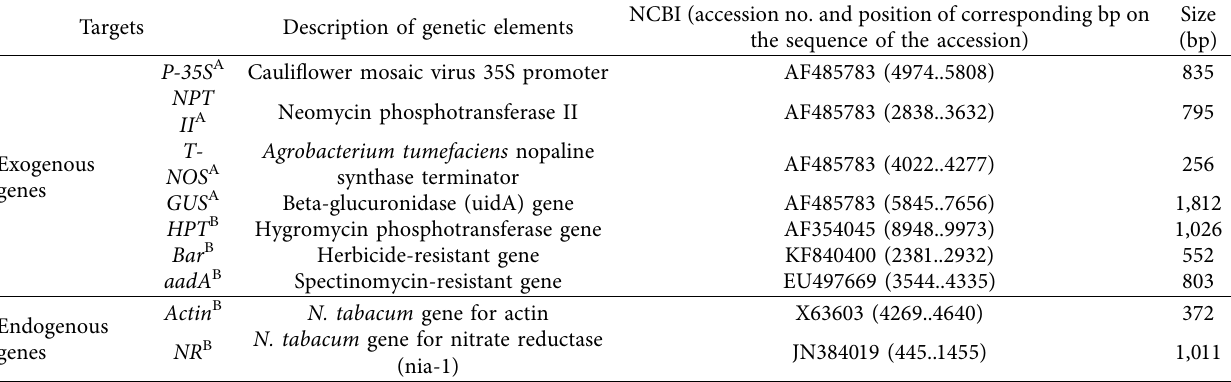
Figure 1: Schematic diagram of pGMT27 for the seven GM tobacco events. P-35S , T-NOS , NPT II , GUS , HPT , Bar , and aadA : fragment of the tobacco exogenous gene in red font; actin and NR : fragment of the tobacco endogenous gene in blue Table 1: Description of the fragments present in the pGMT27 plasmid (18,296bp).